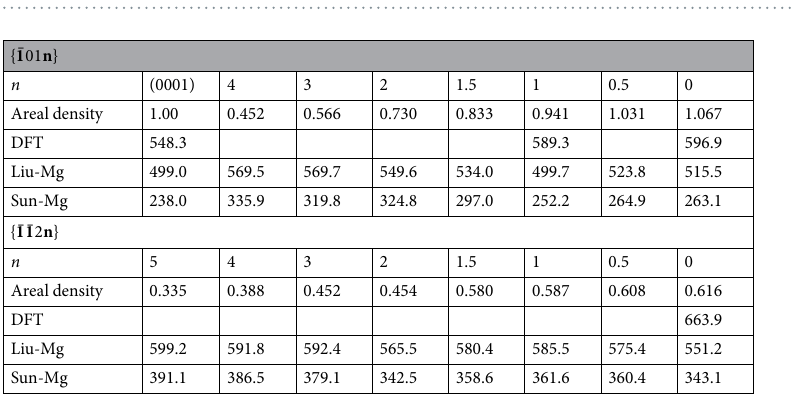
Figure 1. ( a ) The formation energies as a function of atomic areal density. Four compact surfaces were calculated using DFT because of the size limit of DFT calculations. ( b ) The Wulff structure shows two major surfaces (0001) and ¯ {1011} and two minor surfaces ¯ {1010} and ¯ ¯ {1110} .